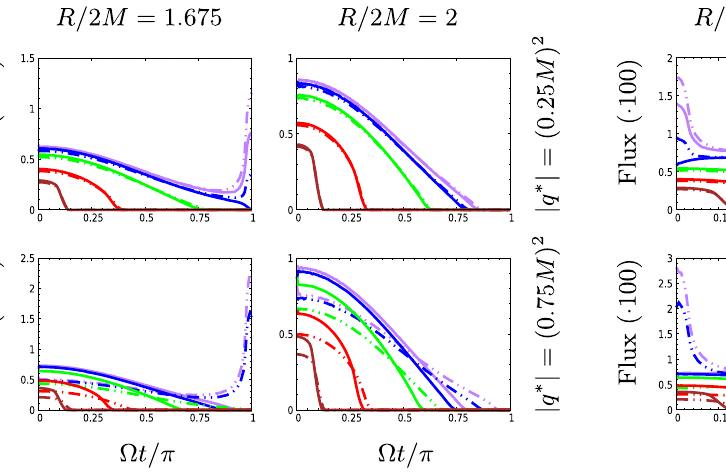
Fig. 8 Pulse profile for antipodal caps. h = 3, ξ = χ = π/ 2. Purple, blue,green,redandbrownlinescorrespondto (cid:11) = 0 . 00,0 . 30,0 . 60,0 . 90 and 0 . 99 respectively. Solid lines correspond to q ∗ > 0 while dashed lines correspond to q ∗ < 0. In the left column we see the characteristic peak due to the cap in opposition generating multiple images. When no cap produces multiple images or is out of the zone of visibility, the flux remains almost constant. In the top row, we see that for small values of | q ∗ | the curves obtained for q ∗ > 0 and q ∗ < 0 are almost identical. In the bottom row, we see that the light curves associated to q ∗ < 0 differ from those in q ∗ > 0, as observed in Fig.